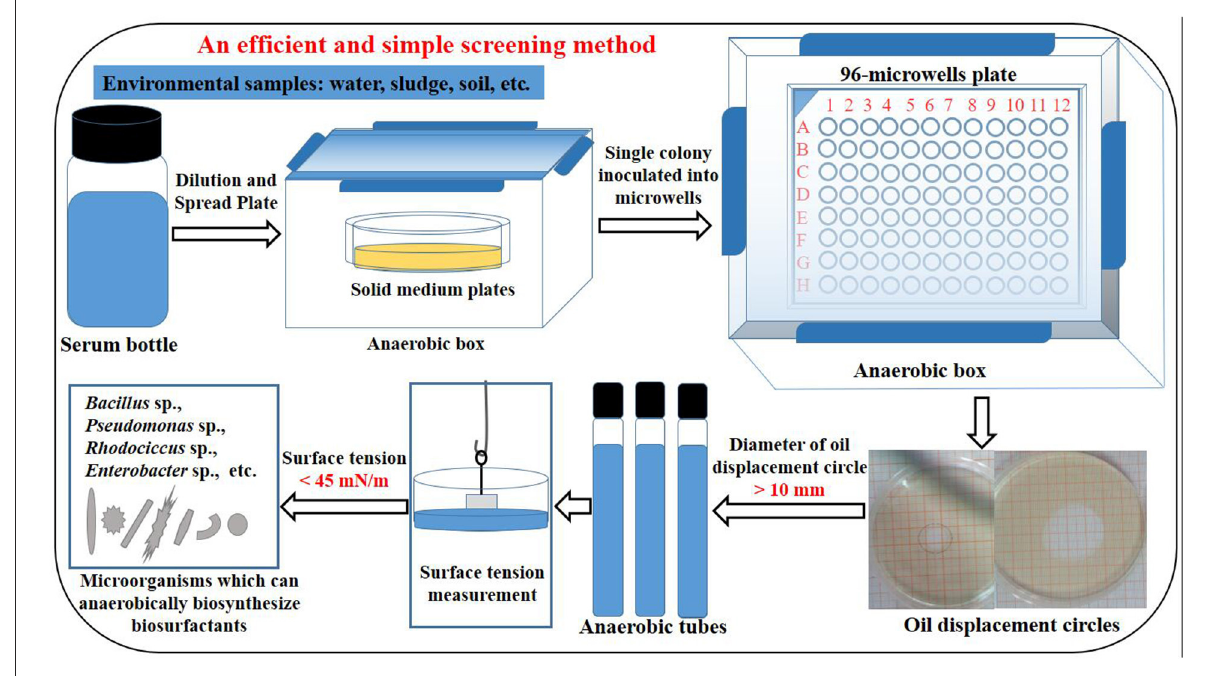
FIGURE1 The procedure of an efficient and simple method for screening microbial strains capable of anaerobic biosynthesis of